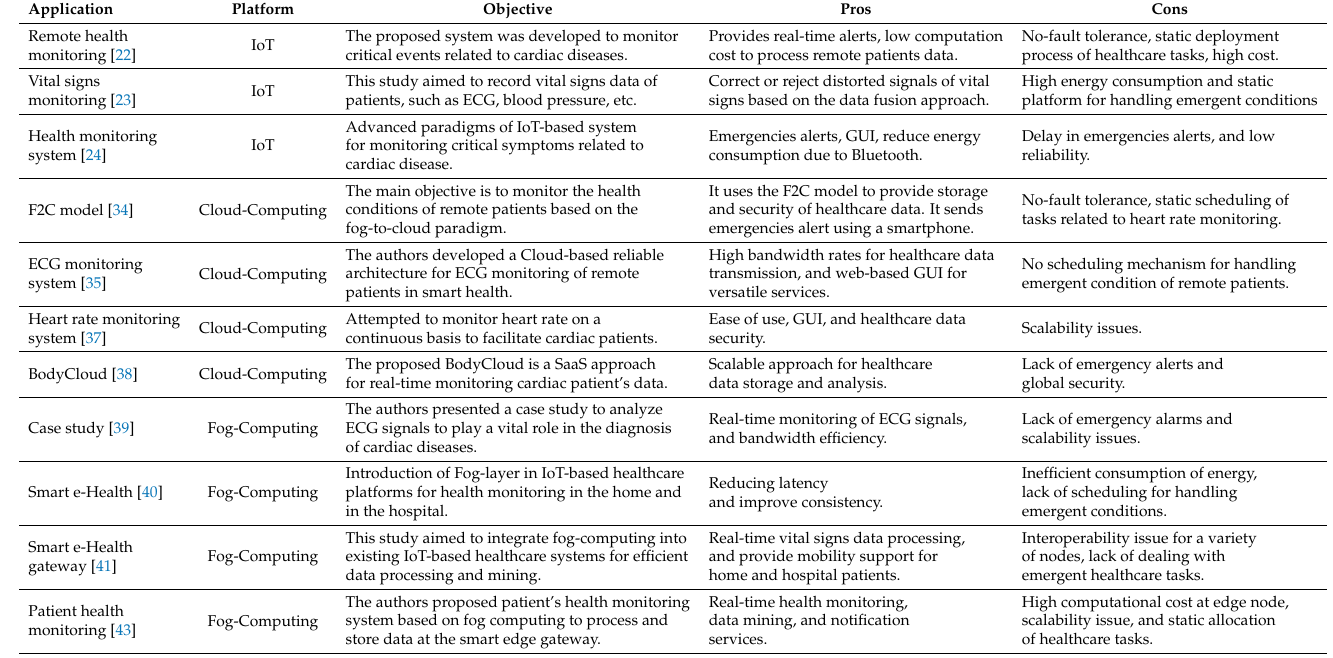
Table 1. Summary of the existing healthcare